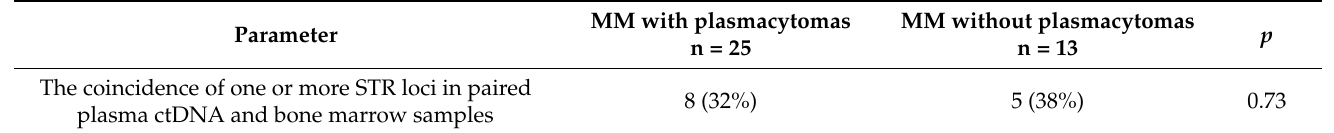
Table 3. LOH frequency in paired plasma ctDNA and bone marrow samples, depending on the presence of plasmacytomas.